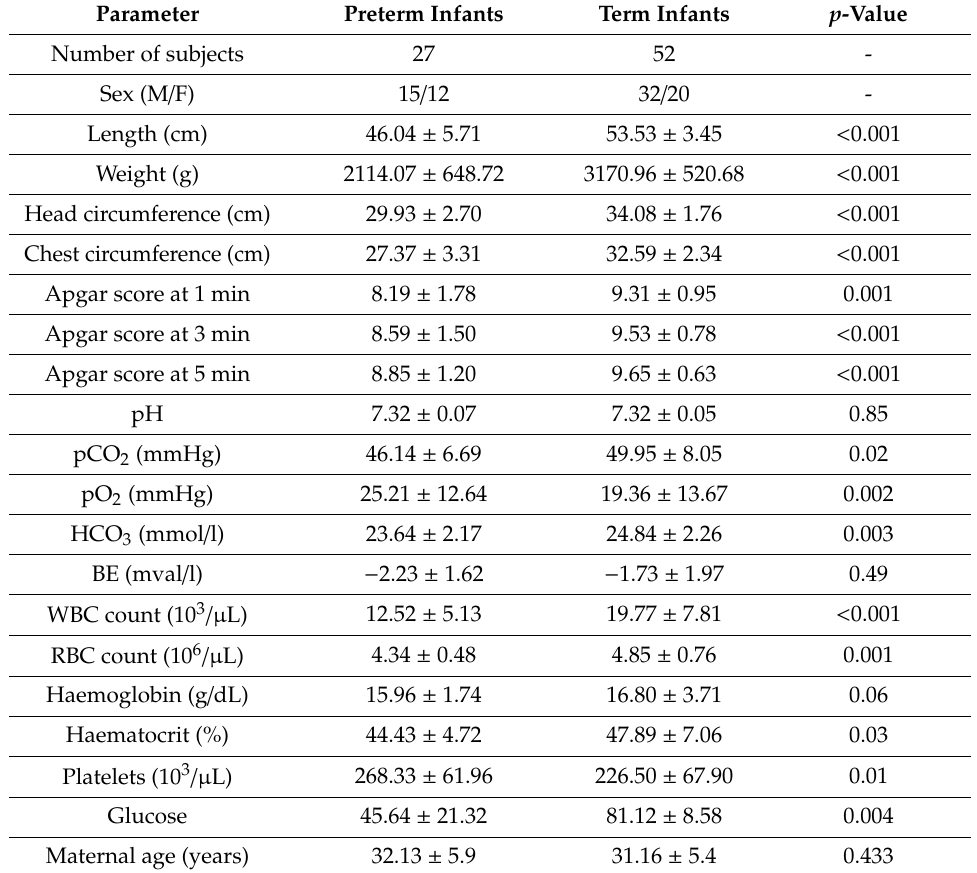
Table 1. Characteristics of the study groups. In bold, p -value < 0.05 considered statistically significant. Parameter Preterm Infants Term Infants p